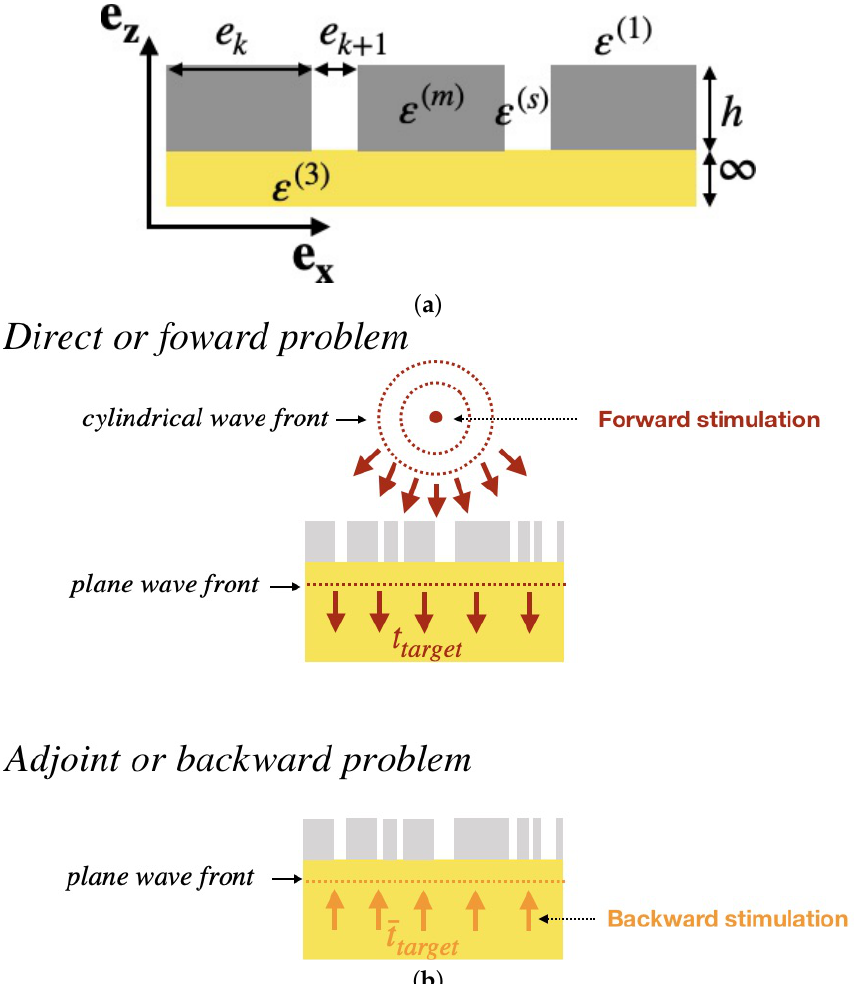
Figure 3. design of a one dimensional flat metalens. ( a ) Schematic of dispersive metal film perforated with a non periodic subwavelength array of 1D nanoslits. ( b ) the adjoint-based optimization method involved two different sources: an electric dipole and a polarized incident plane wave. ( a ) Sketch of the plasmonic dispersive metalens; ( b ) Assessment of the FOM variation